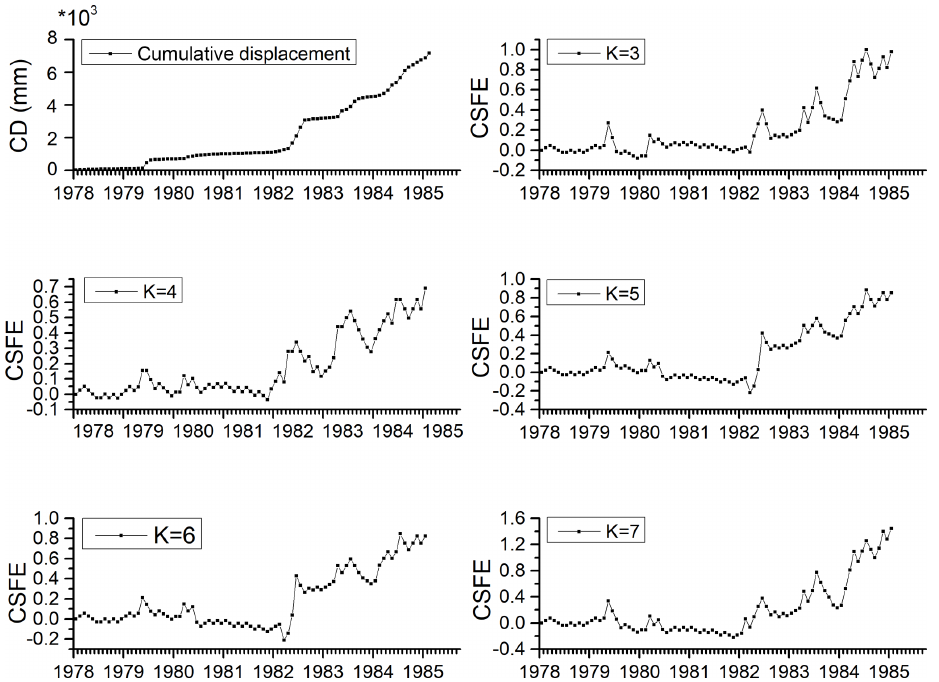
Figure 10. CSFE with different cluster numbers ( K = 3 to 7) of Xintan